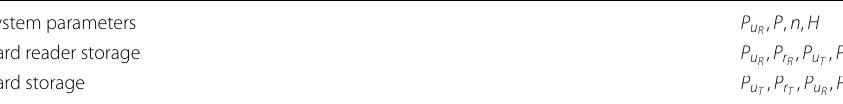
Table 4 System parameters System